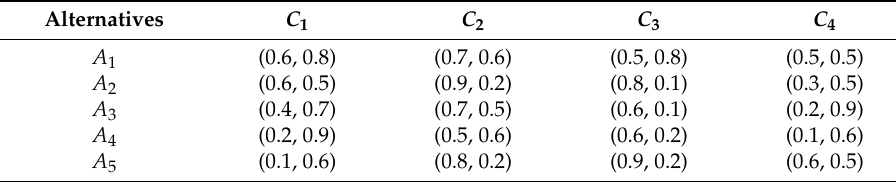
Table 3. The Pythagorean fuzzy decision matrix provided by the E 3